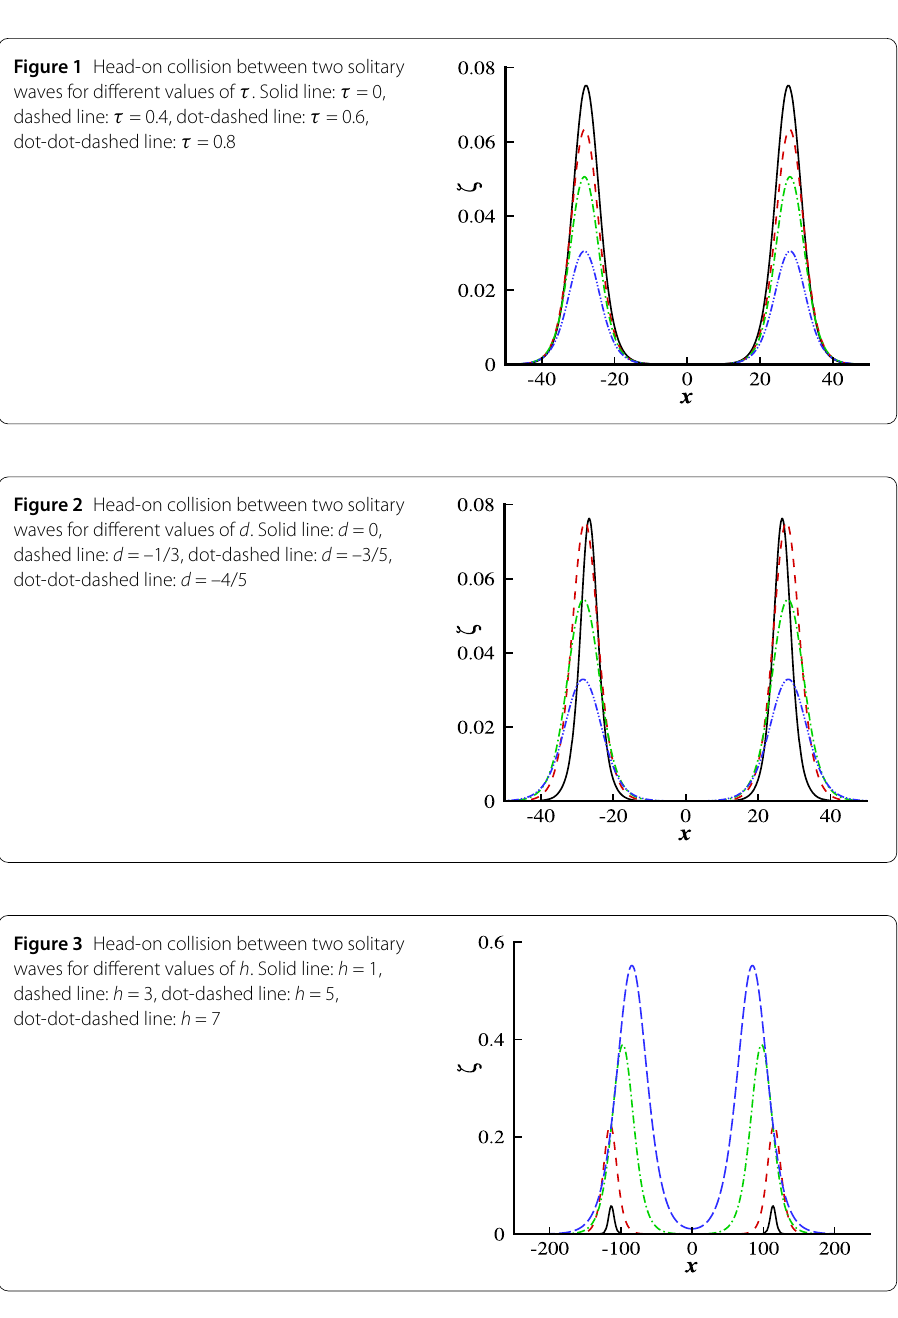
Figure 1 Head-on collision between two solitary waves for different values of τ . Solid line: τ = 0, dashed line: τ = 0.4, dot-dashed line: τ = 0.6, dot-dot-dashed line: τ = 0.8